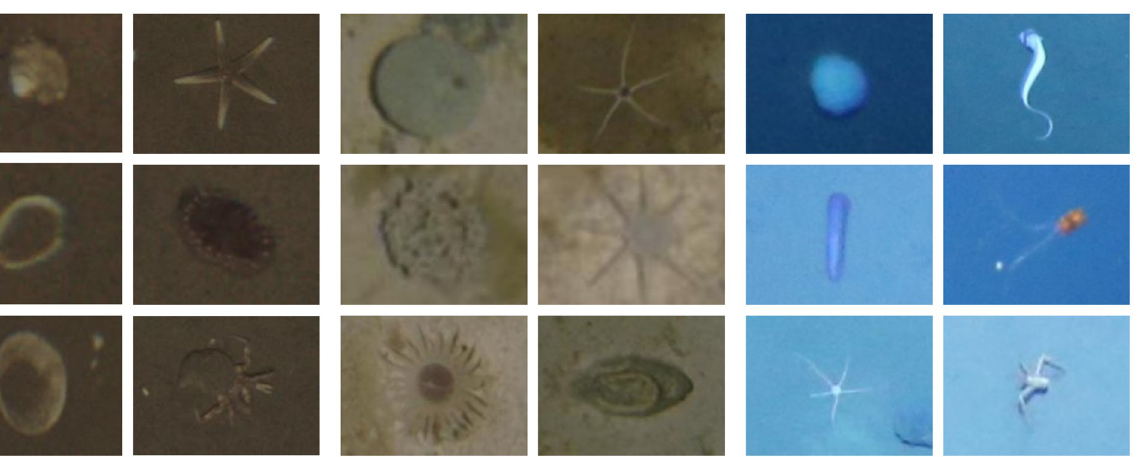
PLOS ONE | https://doi.org/10.1371/journal.pone.0207498 November16,